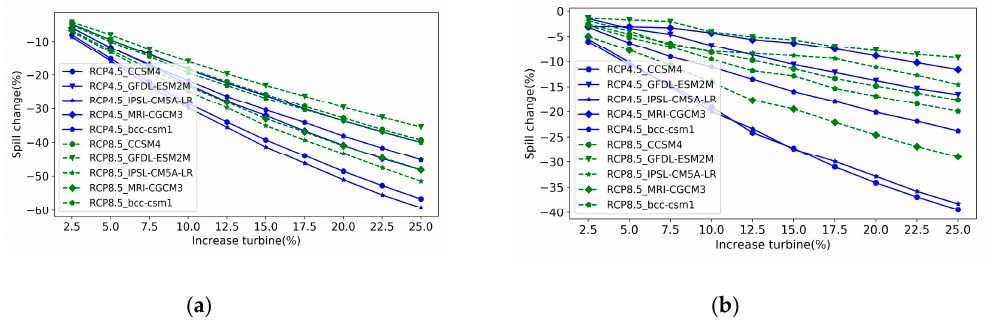
Figure 13. The spill change with the addition of turbine capacity of Gongguoqiao. ( a ) Reduced spillage of Gongguoqiao, and ( b ) reduced spillage of LCCHS.